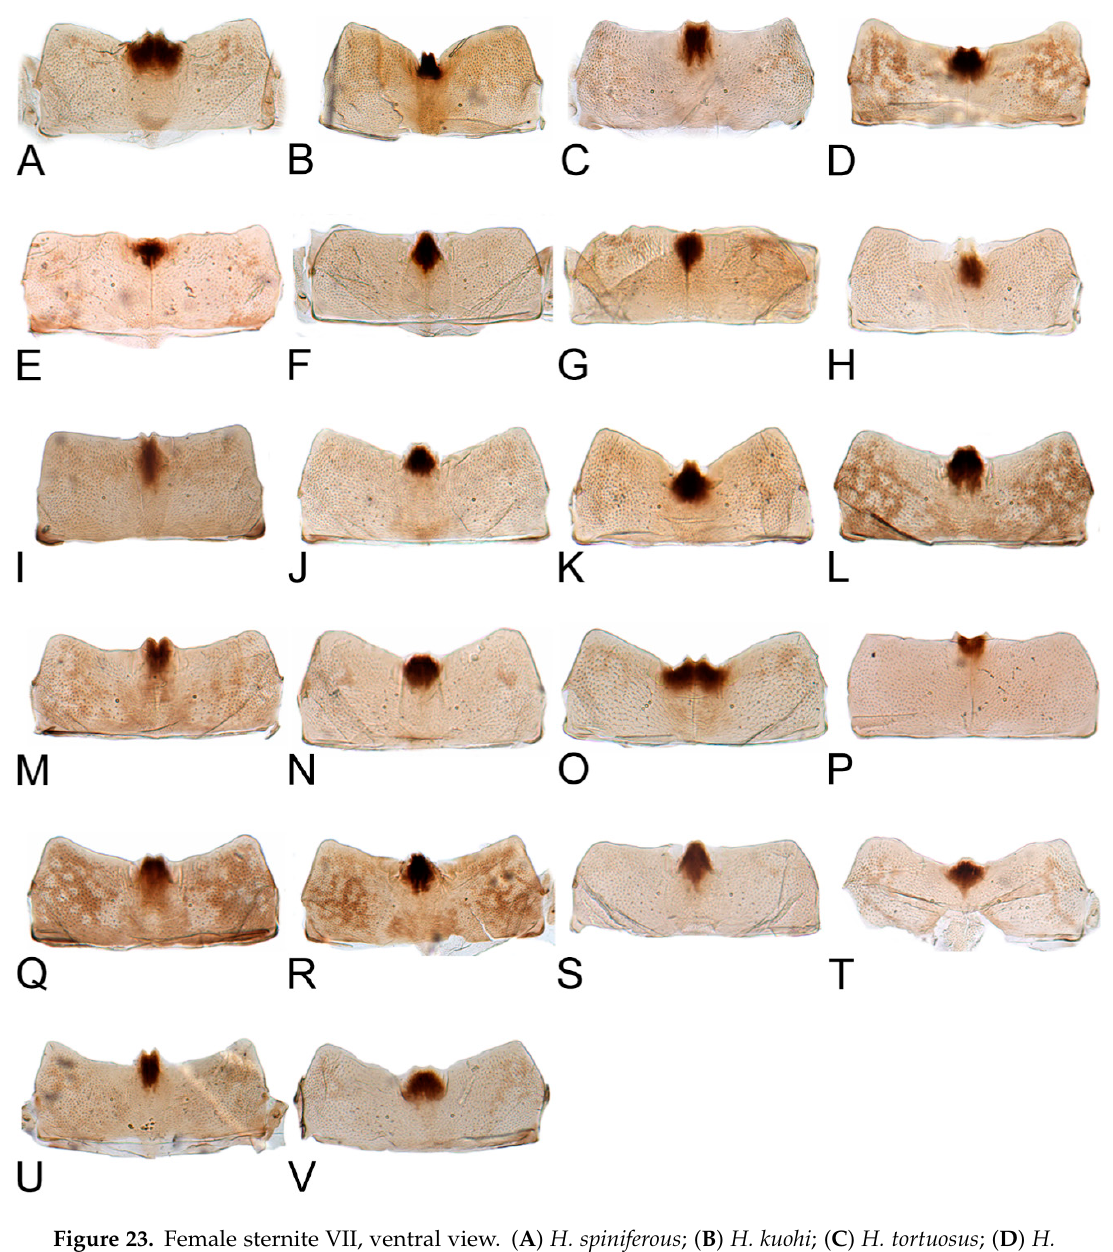
Figure 23. Female sternite VII, ventral view. ( A ) H. spiniferous ; ( B ) H. kuohi ; ( C ) H. tortuosus ; ( D ) H. aberrans ; ( E ) H. knightiellus ; ( F ) H. tenuis ; ( G ) H. subtilis ; ( H ) H. expansivus; ( I ) H. hamuleus ; ( J ) H. hamatus ; ( K ) H. fuscomaculatus ; ( L ) H. phycitis ; ( M ) H. paraphycitis ; ( N ) H. viraktamathiellus ; ( O ) H. triangulus ; ( P ) H. concavus ; ( Q ) H. dietrichi ; ( R ) H. bucephalus ; ( S ) H. fletcheri ; ( T ) H. dichotomous ; ( U ) H. sellatus ; and ( V ) H. rectus .